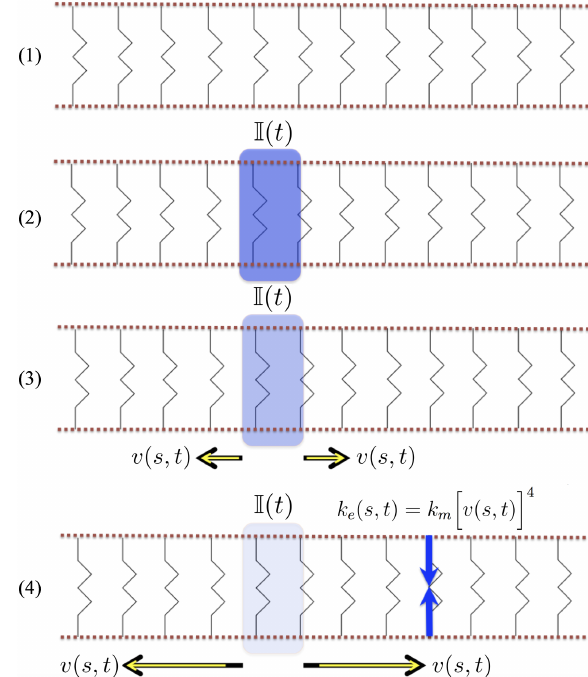
Fig. 7: Schematic of electrodynamical pumping. (1) The tube at rest; the springs connecting the top and bottom of the tube are the muscles. (2)